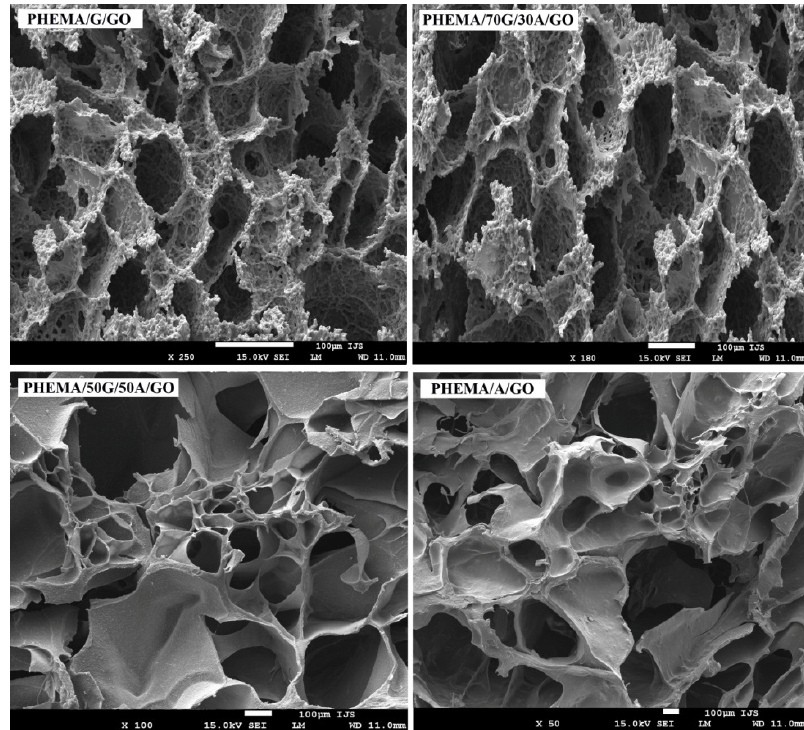
Figure 3. SEM-Micrographs of a cross-section of PHEMA/G/GO, PHEMA/70G/30A/GO, PHEMA50G/50A/GO and PHEMA/A/GO hydrogels.